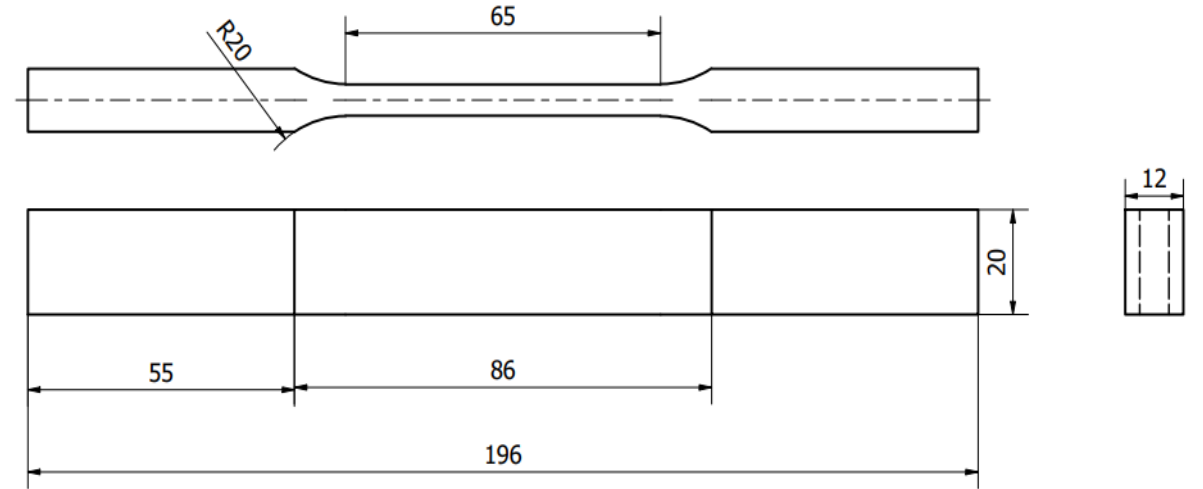
Figure 3. Geometry and dimension of the tensile test specimen.